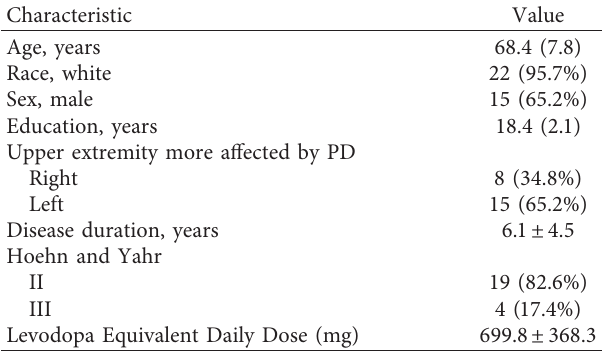
Table 1: Participant demographics ( N �